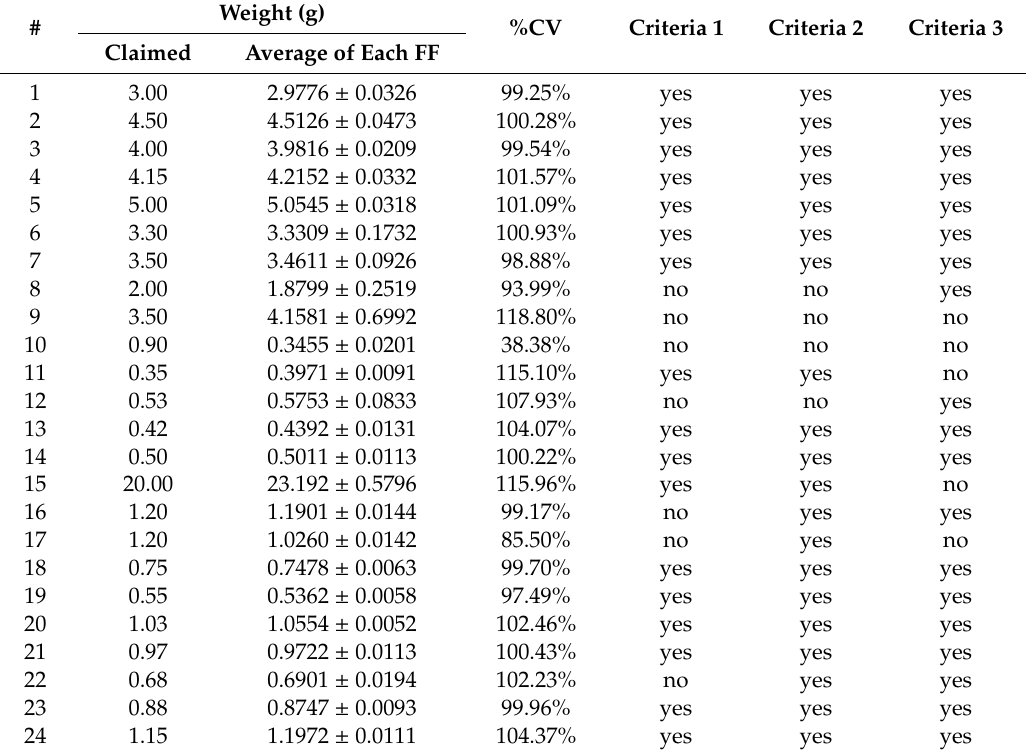
Table 1. Mass uniformity test of the 24 Vaccinium macrocarpon -based dietary